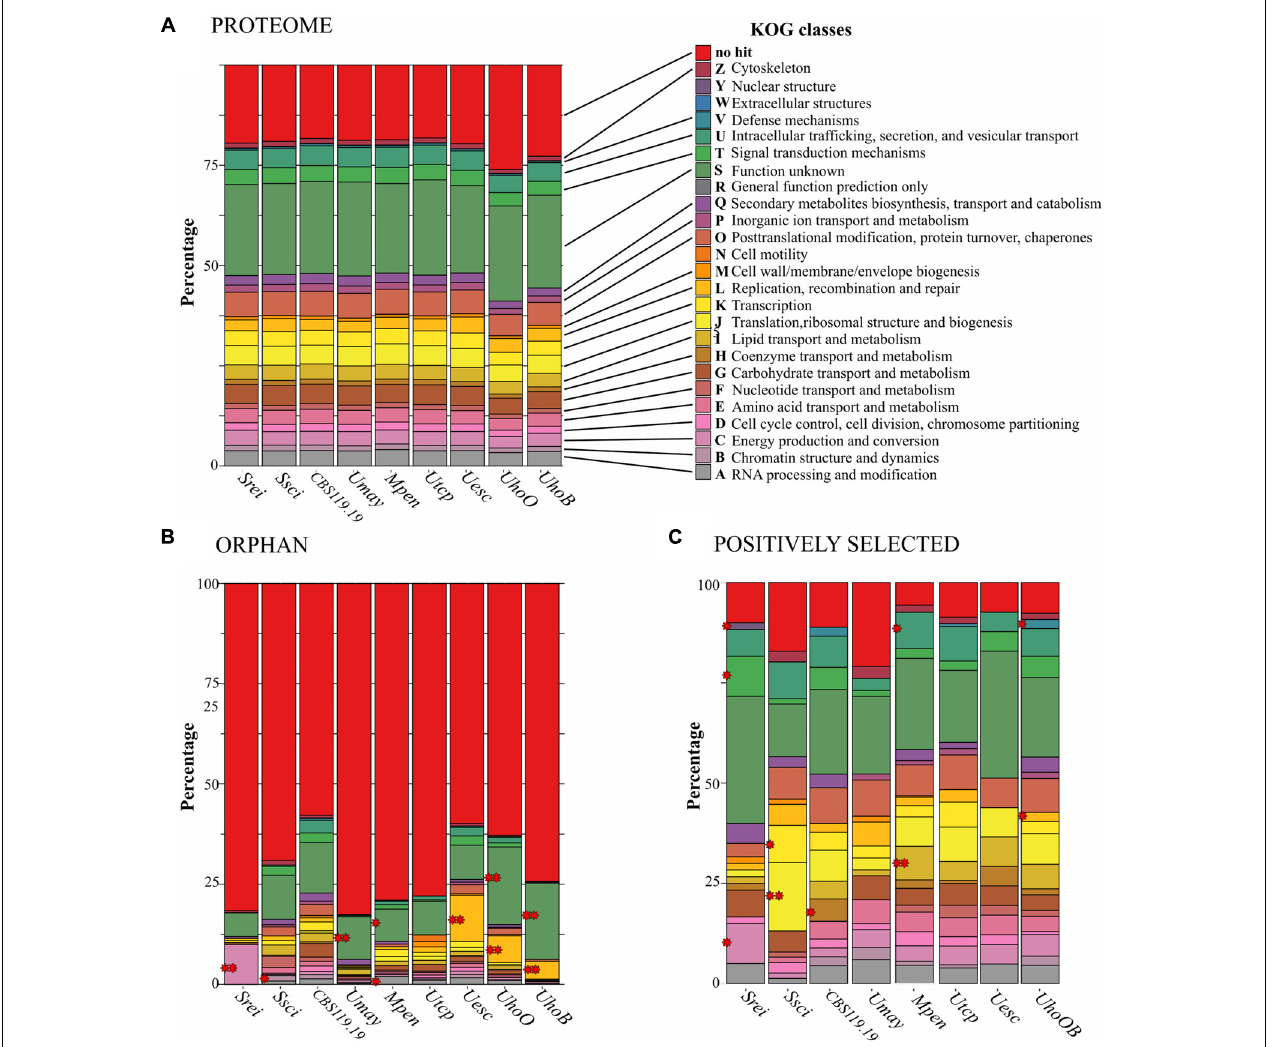
FIGURE 5 | Diversity and distribution of KOG categories among smut protein-encoding gene sets. (A) KOG categories in the genomes of each smut lineage. (B,C) Distribution of KOG categories in orphan and positively selected genes, respectively. Significant enriched categories by Fisher’s exact test are indicated by red asterisks ( ∗ p -value < 0.05, ∗∗ p -adjusted < 0.05). The scientific names were abbreviated according to Table 1 . UhoOB represents the U. hordei species branch marked for positive selection